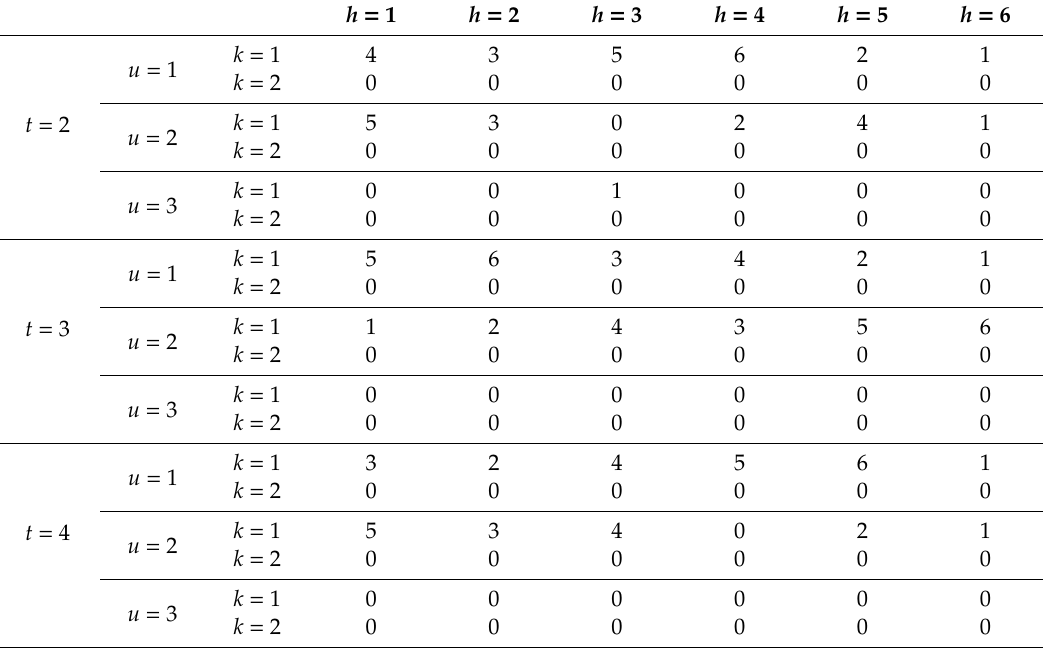
Table A5. Sequence of supplying instruments to hospitals with selected vehicles in period t =